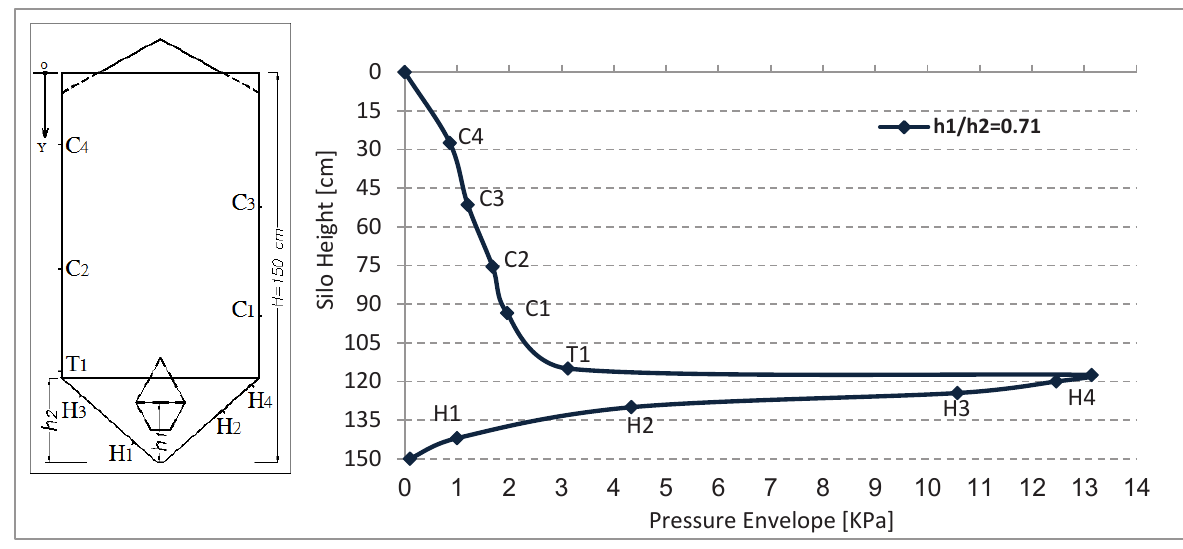
Figure 7: The pressure distribution on the silo wall and hopper with Insert at position h